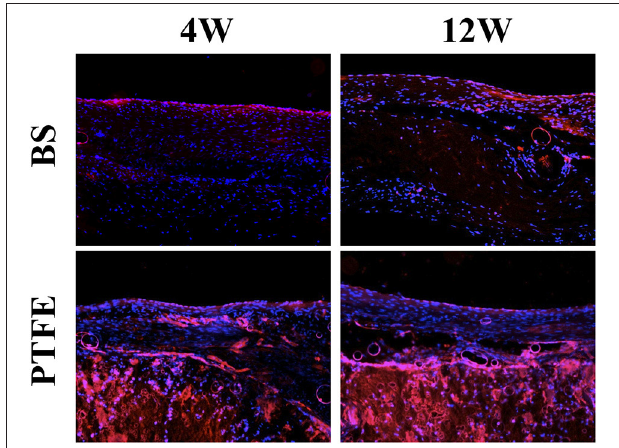
FIGURE 6 | Results of histological examination (stained for vWF). Both patches had complete endothelialization on the endocardial surface in the RVOT-free wall at each time